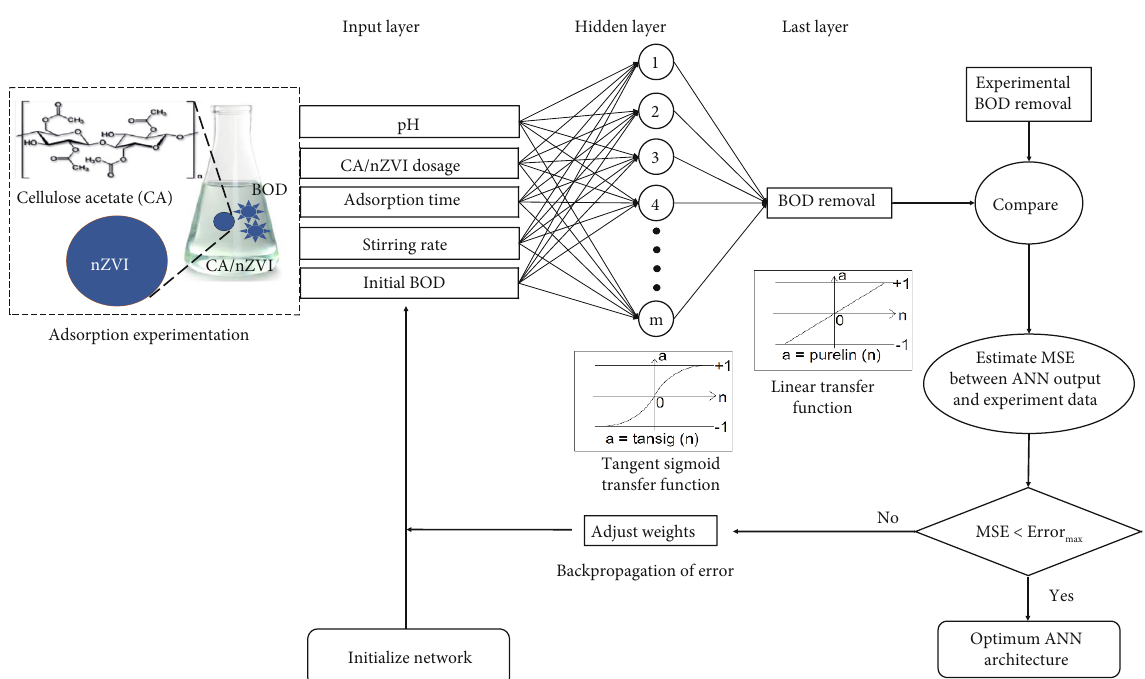
Figure 1: Flowchart of feed-forward back-propagation ANN model for predicting BOD removal e ffi ciency using fi ve adsorption factors, i.e., solution pH, CA/nZVI dosage, time, stirring speed, and initial BOD